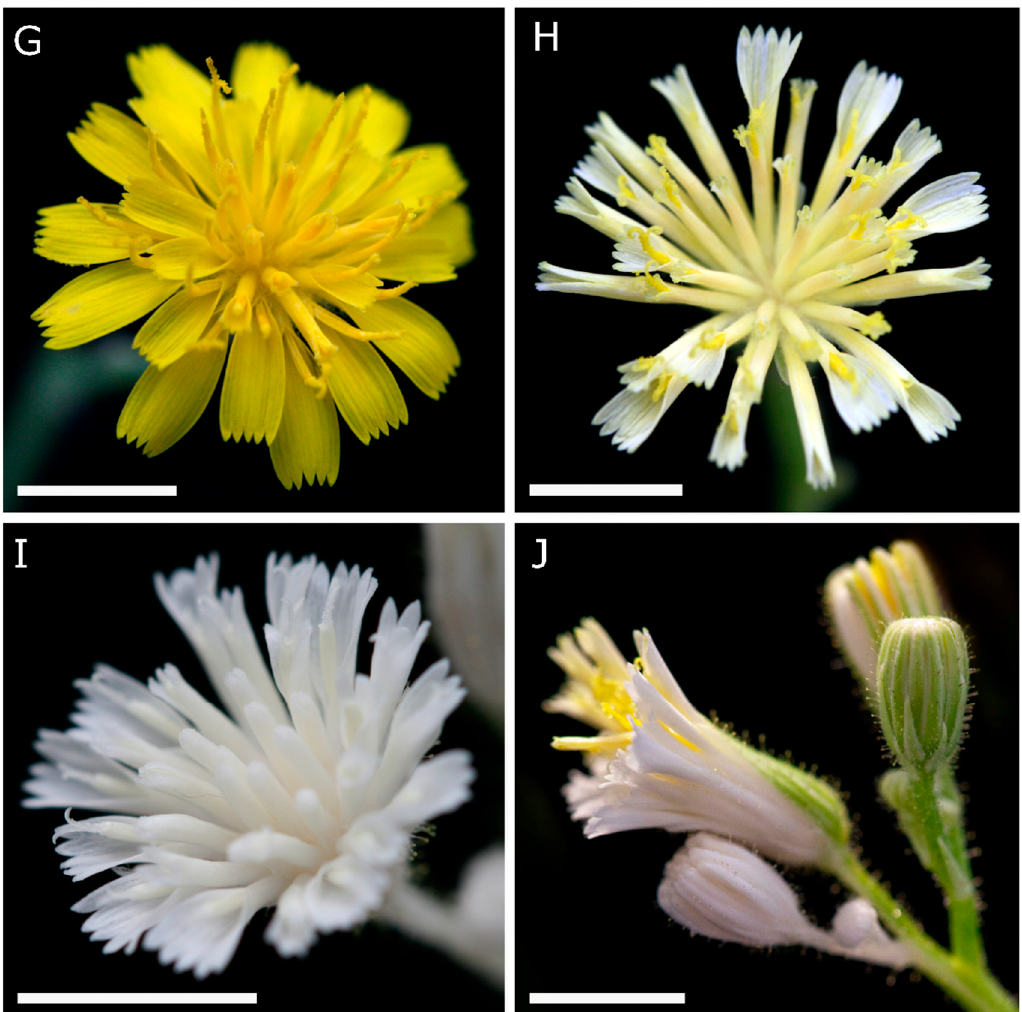
Figure 2. Vegetative and floral phenotypes of CRISPR/Cas9-induced PDS mutations in T0 Hieracium plants. ( A ) Non-edited transgenic plant with green shoots; ( B ) full albino plant; ( C ) sectorial chimera of a single emerging leaf with accumulation of pink anthocyanin pigments; ( D ) patch of albino cells on the edge of an expanding leaf; ( E ) chimeric leaf visible within a whole rosette; ( F ) leaf with variegated patchy albino appearance; ( G ) flower from a nontransgenic plant at anthesis; ( H ) flower from a chimeric pds transgenic at anthesis displaying pale-yellow to white petals within each floret, but normal yellow-colored bilobed stigmas; ( I ) full albino flower showing bleached florets, including white stigmas; ( J ) chimeric plant with both normal, sectorial and full albino capitula, visualized as white sepal coloration. Scale bar = 5 mm ( A – C , E – J ) or 1 mm ( D